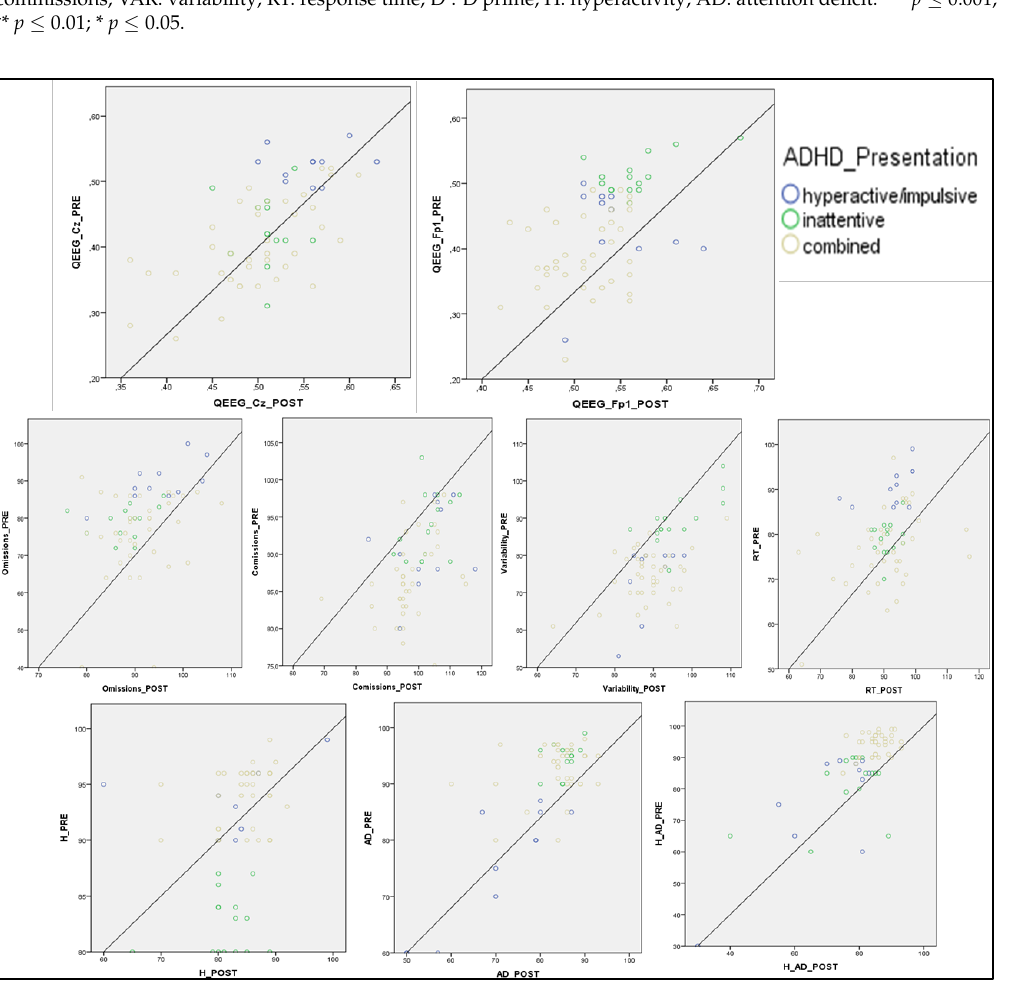
Figure 1. Scatter plot for the variables of cortical activation (Cz and Fp1), execution (omissions, commissions, variability, and RT) and observed symptomatology (H: hyperactivity, AD: attention deficit) considering the three types of presentation. Note: OM: omissions; COM: commissions; VAR: variability; RT: response time; D’: D prime; H: hyperactivity; AD: attention